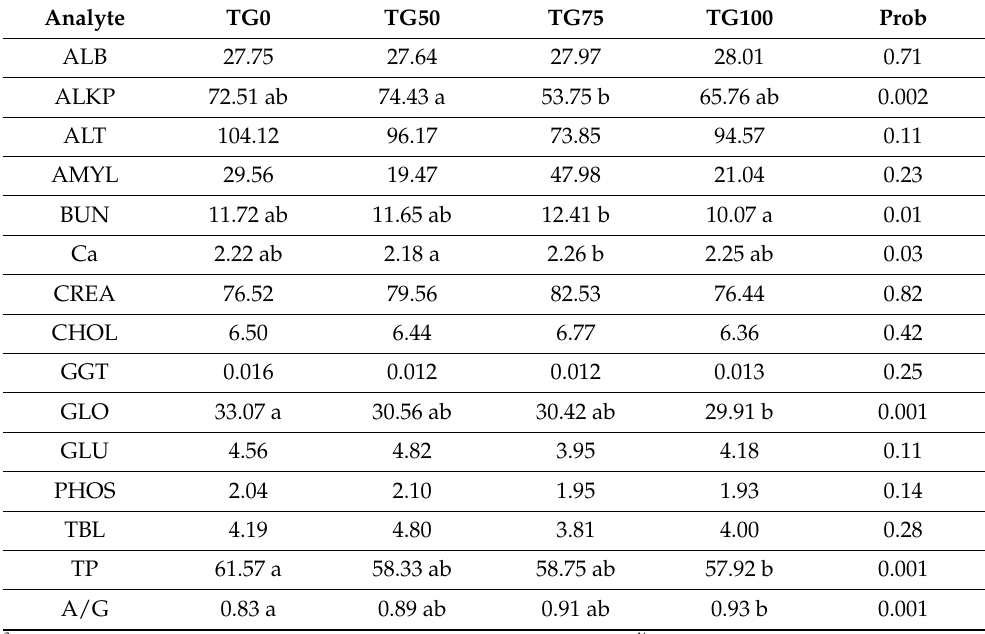
Table 3. Back-transformed values of blood analytes of the tolerant groups and the probabilities of differences among groups (Prob) §,¥ .